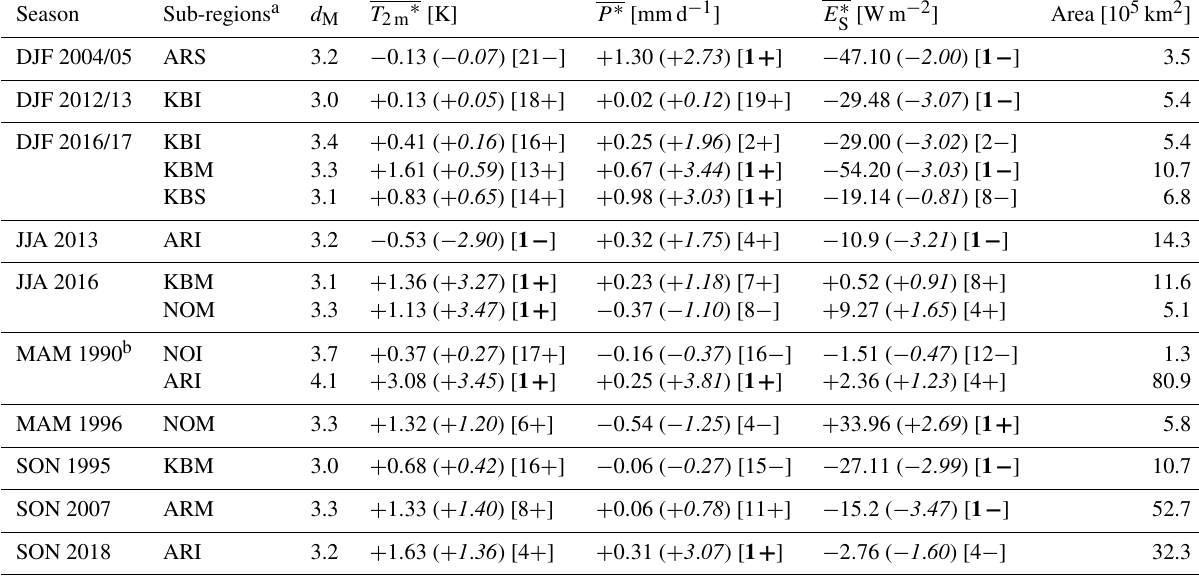
Table 2. Extreme seasons in DJF, JJA, MAM and SON, including the affected sub-regions and respective Mahalanobis distance ( d M ; see Sect. 2.3); the seasonal-mean anomalies of T 2m , P and E S (standardized seasonal-mean anomalies in parentheses; italics); and affected area per sub-region. The rank of each seasonal-mean anomaly with respect to all seasons is given in brackets (bold), with “1 + ” denoting rank 1 in terms of a positive anomaly (e.g., wettest season) and “1 − ” denoting rank 1 in terms of a negative anomaly (e.g., driest season).